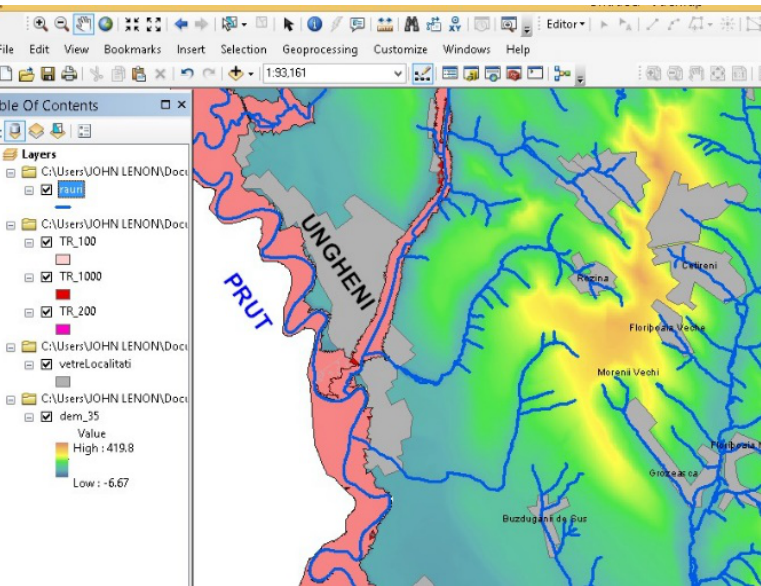
Figure 3. Digital Elevation Model, Flood Risks. Source: SRTM by NASA.